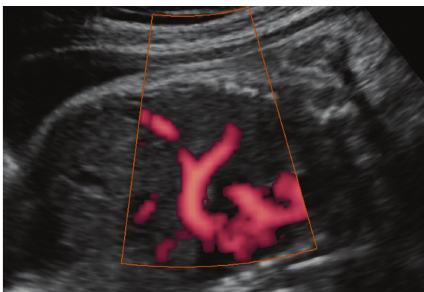
Figure 1: Two-dimensional ultrasound finding in a fetus with ring chromosome 15 at 19 weeks of pregnancy showing liver herniation into the thorax due to congenital diaphragmatic hernia.